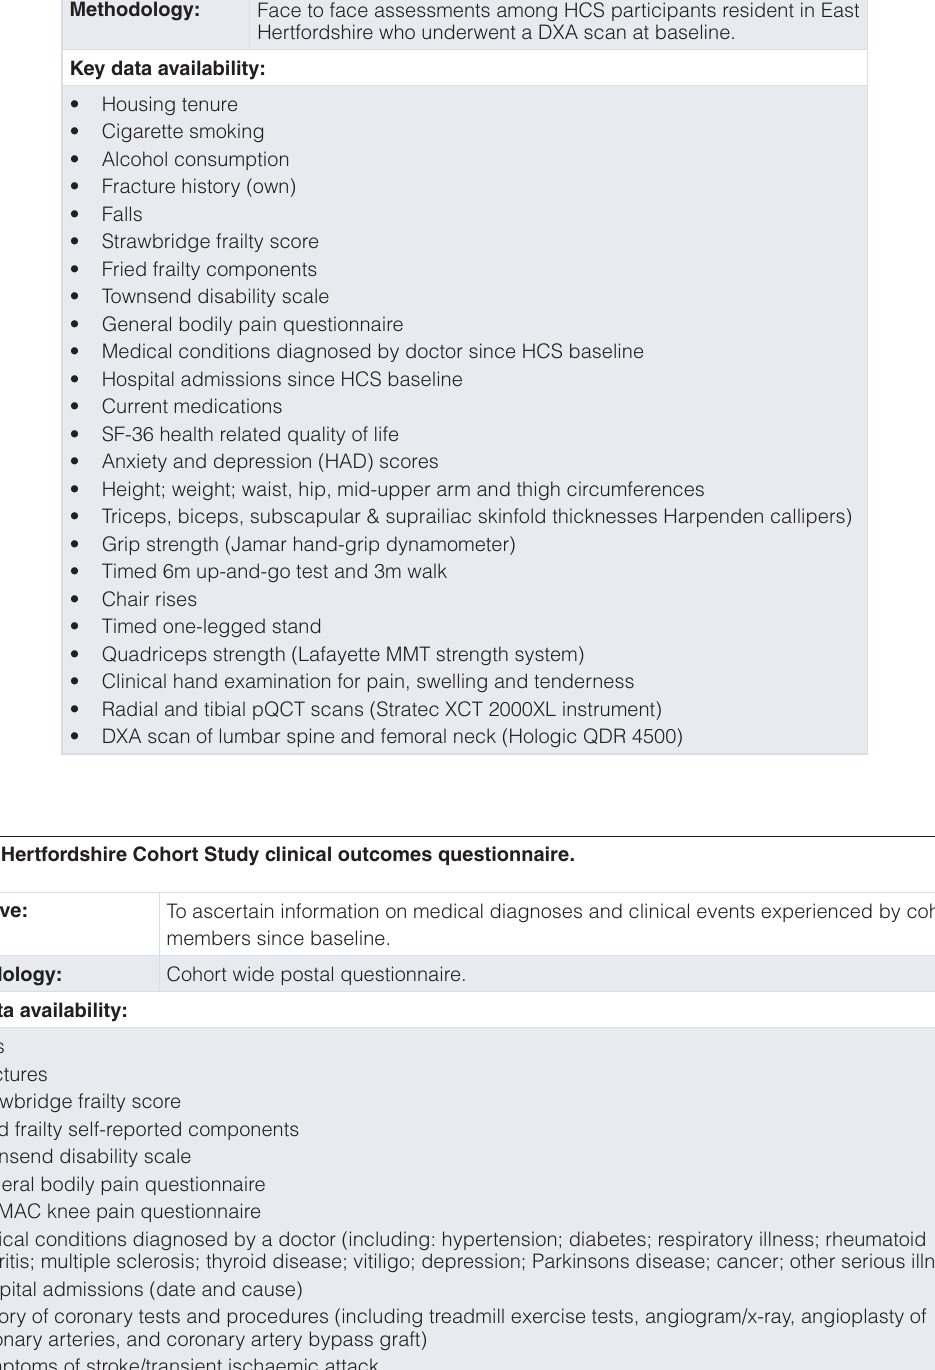
Table 3. Hertfordshire Cohort Study Musculoskeletal Follow-Up study (MSFU). Objective: Methodology: